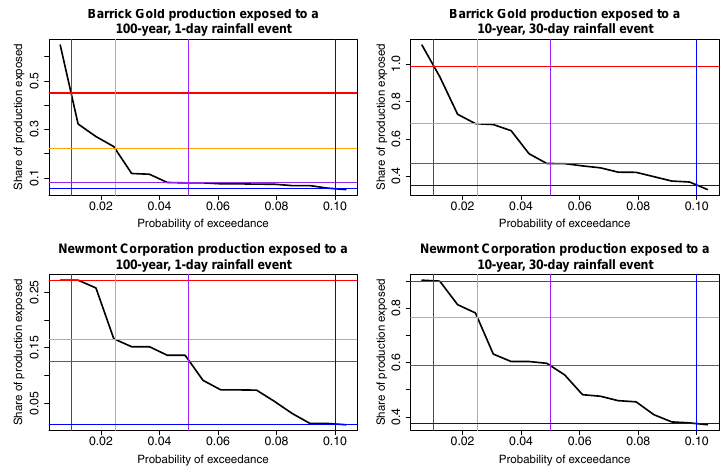
Figure 7. Fraction of company production value exposed, as a function of annual exceedance probability for 100-year, 1-day and 10-year, 30-day events for Barrick Gold and Newmont based on the 20CR data.